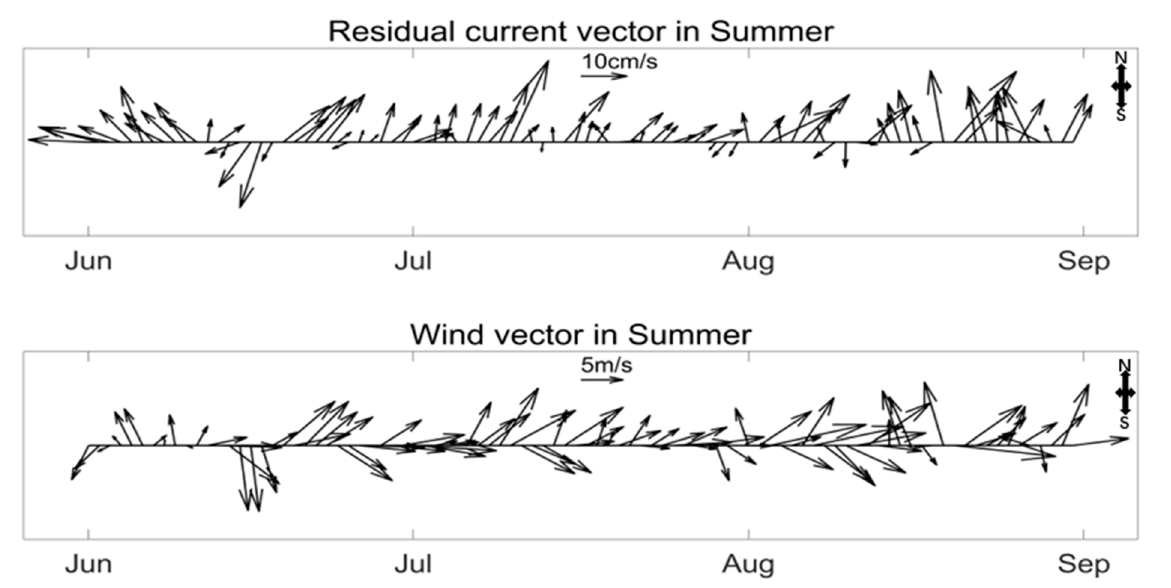
Figure 8. Vector time series of residual currents and winds in the summer. Wind speed in autumn is between 0 and 19 m/s, and the residual current velocity is between 0 and 36 cm/s. Averaged residual currents’ velocity, the maximum residual currents’ velocity, averaged wind speed and maximum wind speed of other currents are only lower than in the winter. The direction of residual current flow in autumn is mainly from south to north, as is shown in Figure 9. Wind direction distribution in autumn is diverse, but southwest is still the dominant direction, followed by southeast. The correlation between wind speed and residual current velocity in autumn is the highest, as is shown in Figure 10. Correlation coefficients of zonal and meridional components between residual currents vectors and wind vectors are 0.8 and 0.75, respectively. Statistically good agreement between wind direction and residual currents direction existed in autumn. This indicates that wind has a significant impact on driving residual current flow in